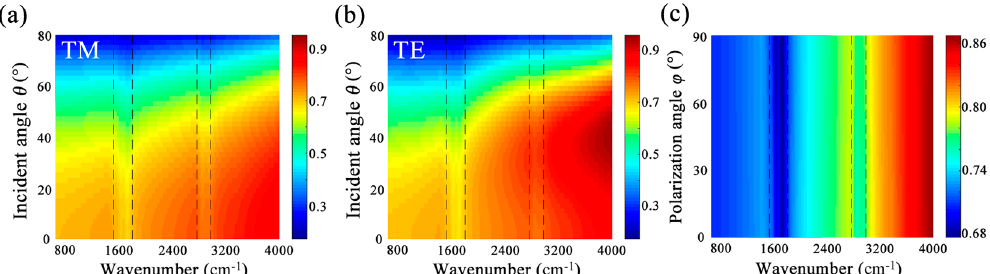
Figure 7. Transmittance of 3D MRGB covered with protein and lipid molecules as functions of wavenumber and incident angle θ of TM ( a ) and TE ( b ) polarization, as well as wavenumber and the polarization angle φ under normal incidence ( c ). Dashed vertical black strips outline the vibrational bands of protein and lipid molecules.